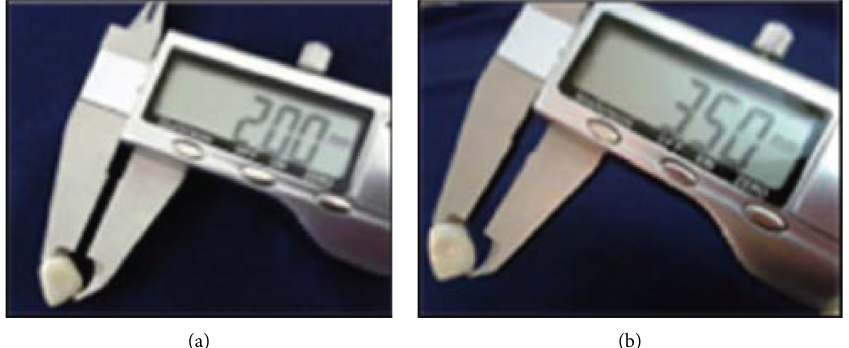
Figure 4: Checking thickness of the finished CAD/CAM zirconia all-ceramic crown: (a) all-ceramic crown of 2mm incisal thickness; (b) all- ceramic crown of 3.5mm incisal thickness.